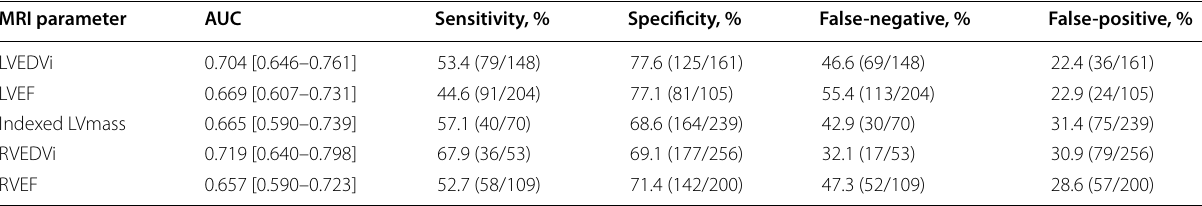
51% for detecting abnormal cardiac MRI parameters by Receiver operating characteristic =